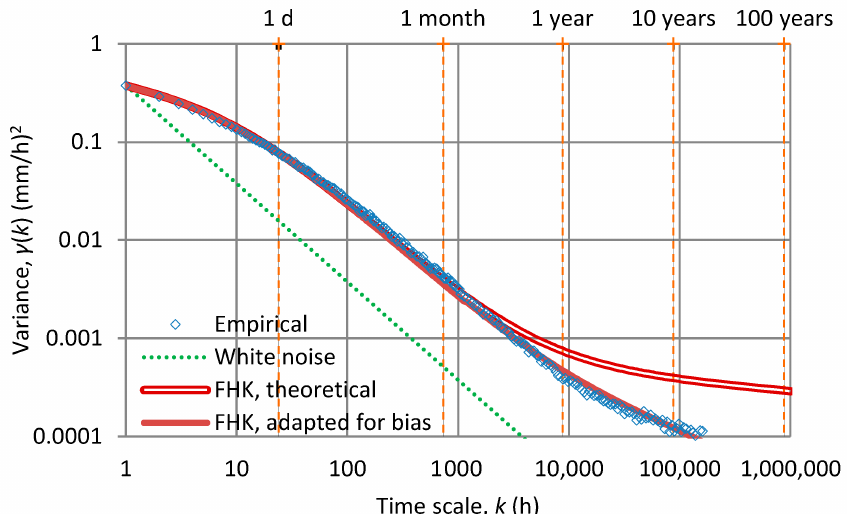
Figure 5. Climacogram of precipitation in Bologna; both hourly and daily data have been used to estimate the empirical climacogram. FHK stands for filtered Hurst-Kolmogorov process and has the mathematical expression of Equation (7) with fitted parameters H = 0.95, M = 0.05, α = 16.4 h, 2 /h 2 and λ 2 /h 2 λ 1 = 0.000864 mm 2 = 1.506 mm